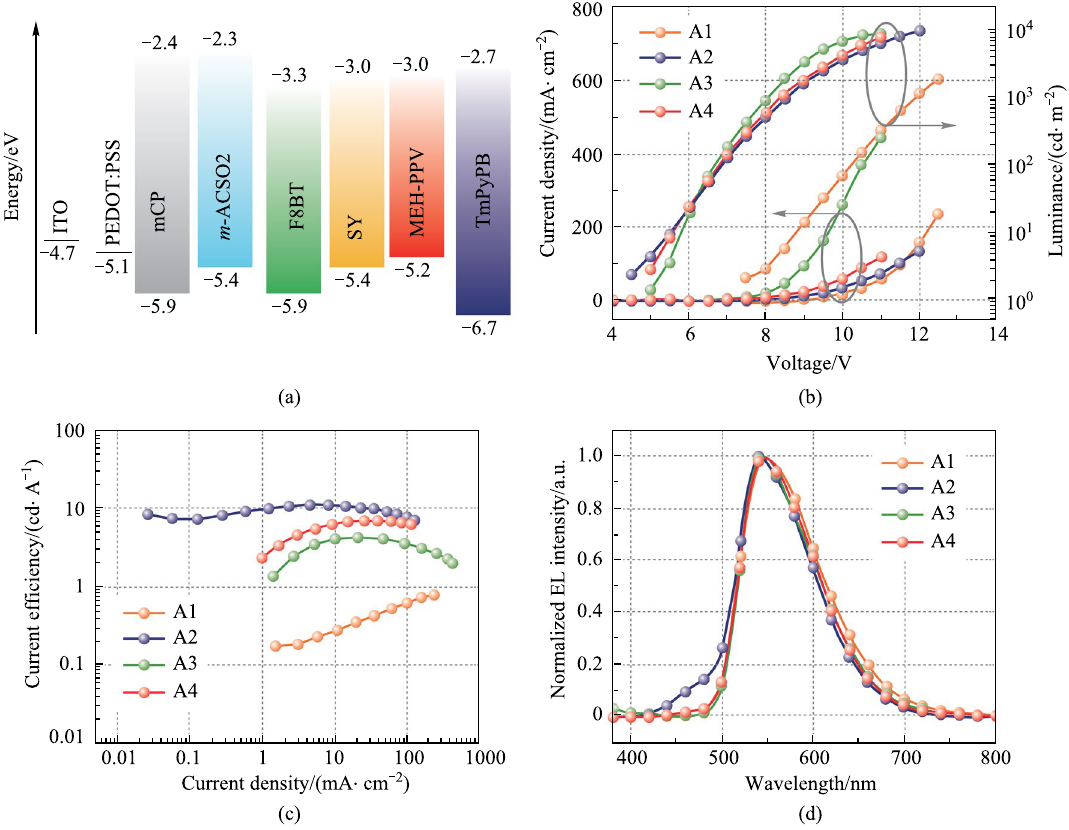
Fig. 5 a Schematic energy level alignment of the materials used in constructing the devices. b Current density–voltage-luminance characteristic curves. c Current efficiency versus current density curves. d Normalized EL spectra of the devices A1–A4 with F8BT (A1), m -ACSO2:F8BT (A2), mCP:F8BT (A3), and mCP: m -ACSO2:F8BT (A4) as the emitting layers,